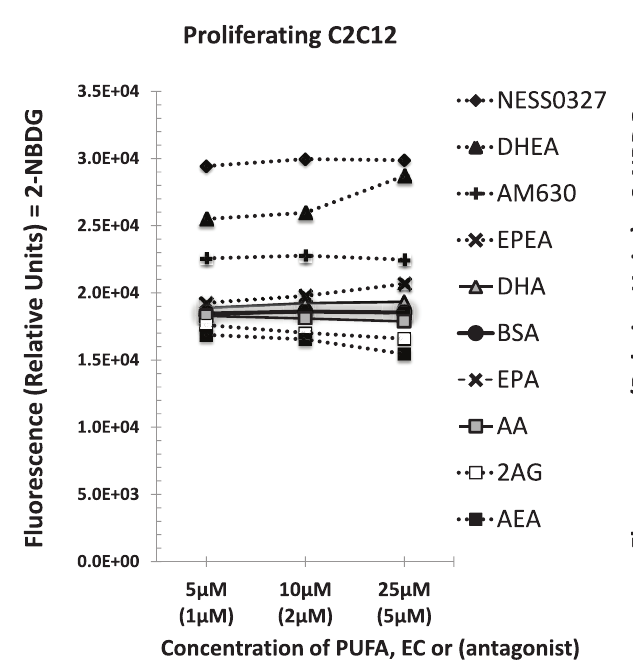
line) , DHA, DHEA, EPEA, AM630, and NESS0327 had higher glucose uptake while AA, AEA, and 2-AG had lower glucose uptake. In differentiated cells compared to the BSA vehicle control, glucose uptake was lower for AEA and 2-AG treatments while all other treatments were higher. Data were analyzed by a One-Way ANOVA and Tukey’s mean separation test at α = 0 . 05.The mean values and pooled s.e.m are shown in the supplemental materials Table S3